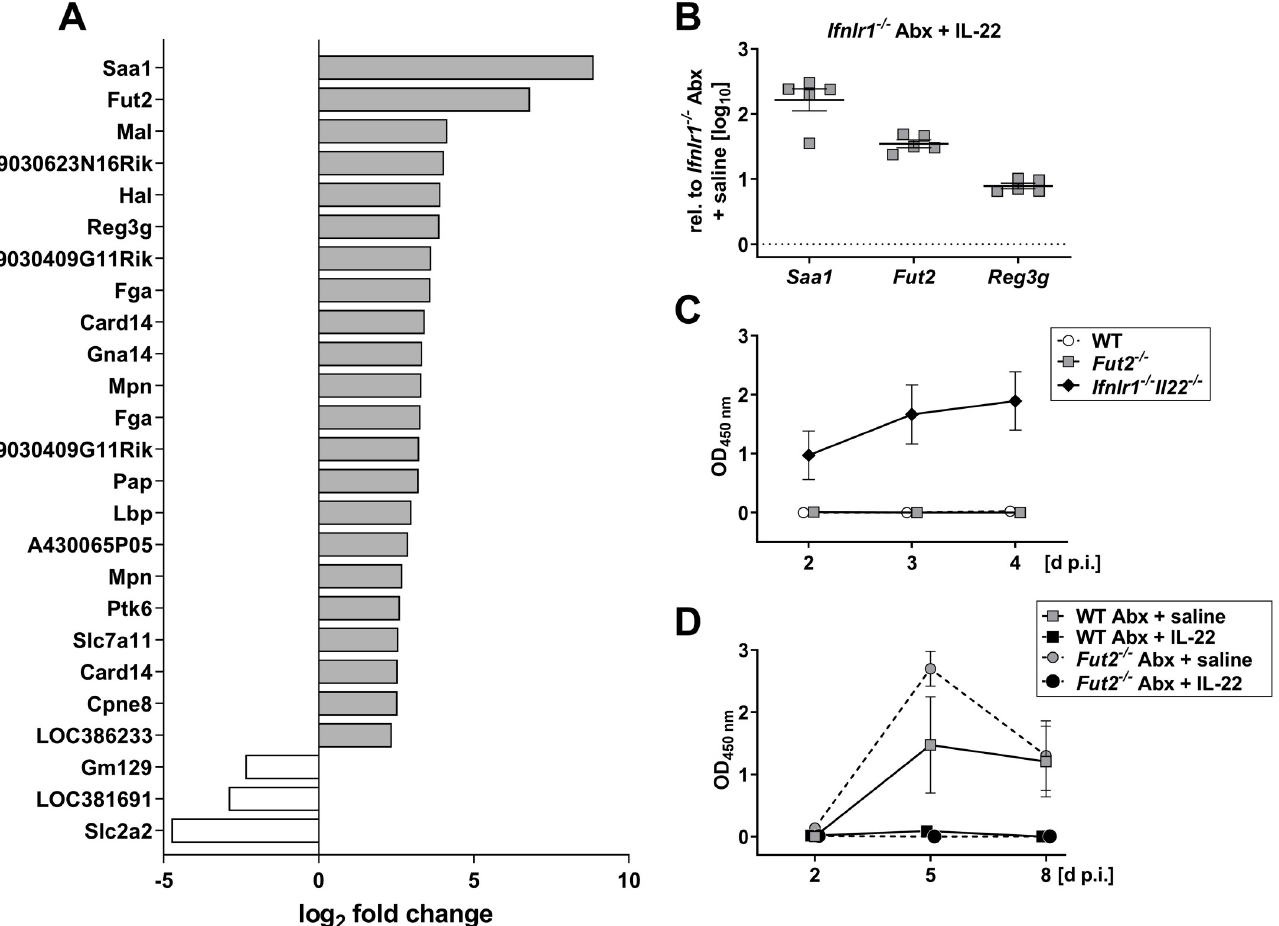
Fig 4. IL-22 regulates a distinct set of genes in antibiotic-treated Ifnlr1 -/- mice, but the Fut2 gene plays no decisive role in rotavirus resistance. (A) Four h prior to preparation of ileum samples for transcriptome analysis, antibiotic-treated Ifnlr1 -/- mice (n = 5 per group) were treated with either buffer or 1 μ g of IL-22. Genes up- or downregulated at least 5-fold on average in IL-22-treated mice are listed. For all listed genes, variation between samples from the different mice was small (p value < 0.01 for every data point) and was part of the original filter used to acquire the data. (B) Verification of IL-22-mediated induction of Saa1 , Fut2 and Reg3g by RT-qPCR. Symbols represent individual mice, and bars represent means ± SEM. (C) Fut2 -/- mice with undisturbed microbiota (n = 6) were orally infected with 2.4x10 4 ID 50 of murine rotavirus strain EDIM and viral antigen levels in fecal samples were analyzed by ELISA. WT (n = 6) and Ifnlr1 -/- Il22 -/- (n = 6) mice served as negative and positive controls, respectively. (D) Fut2 -/- mice with depleted microbiota (n = 6 per group) were treated daily with saline or IL-22 (extended treatment as described in Fig 3) prior to infection with 2.4x10 4 ID 50 of murine rotavirus strain EDIM. Antibiotic-treated WT mice (n = 4–5 per group) served as controls. Symbols in (C) and (D) represent means ± SEM.